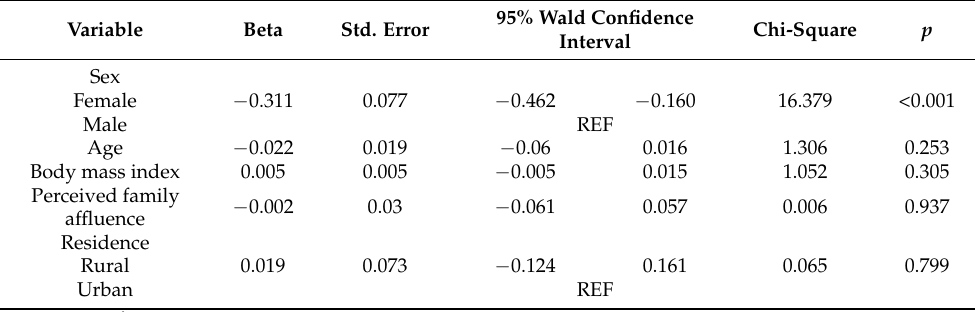
Table 3. Predictors of changes in moderate to vigorous physical activity during the COVID-19 pandemic.